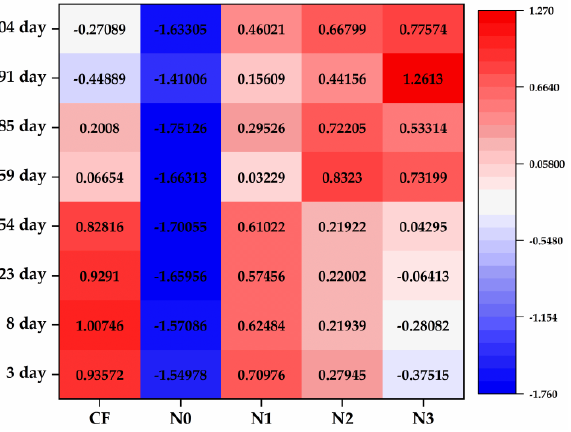
Figure 1. Heat map analysis of soil urease activity in different treatments.